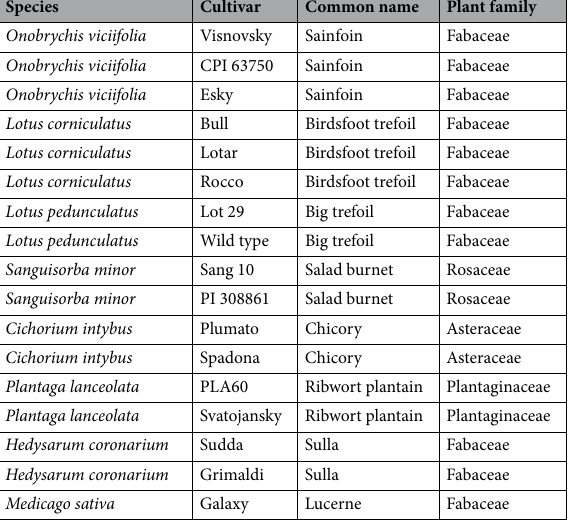
Table 4. The plant species and their cultivars used in the greenhouse